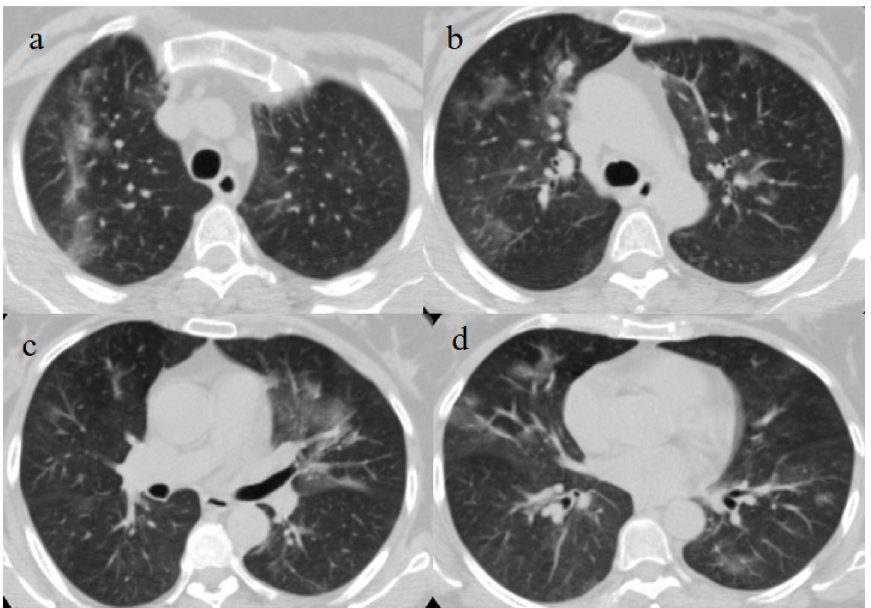
Figure 2. Chest CT performed in the emergency department on 7 June, showing GGO areas with a peripheral and central distribution in a typical presentation of COVID-19 pneumonia in a multifocal involvement. ( a , b ) GGO areas in the superior lobes, ( c ) the middle and left superior lobes, and ( d ) the inferior lobes.